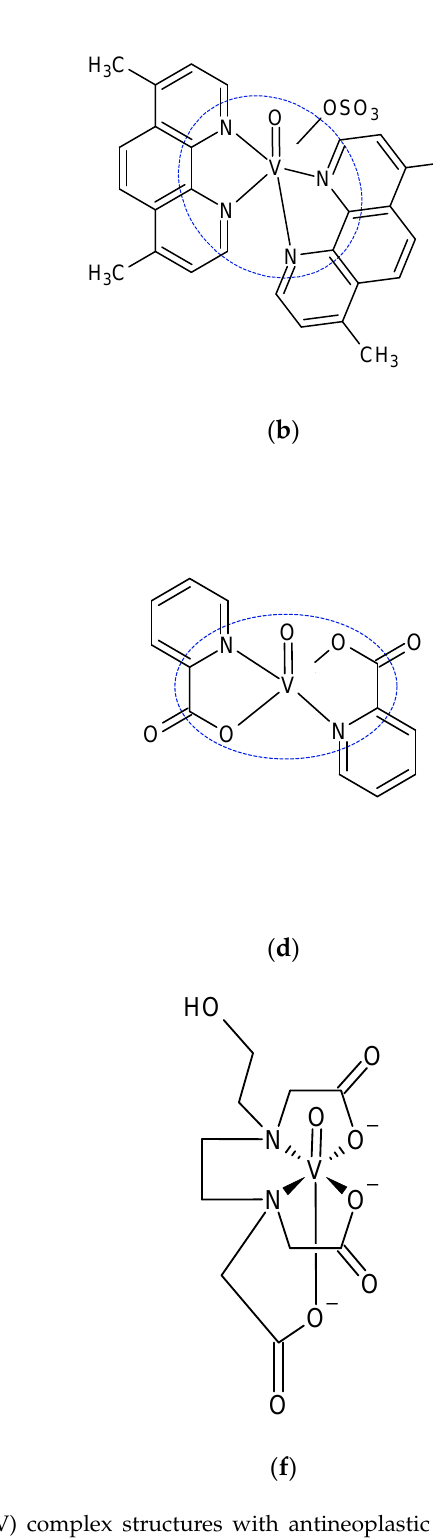
Figure 1. ( a ) oxidation states of vanadium in an aqueous solution, their color and examples of chem- ical compounds; ( b ) distribution diagram of V(IV) hydrolysis at 10 nM. Reprinted with permission from ref. [10].